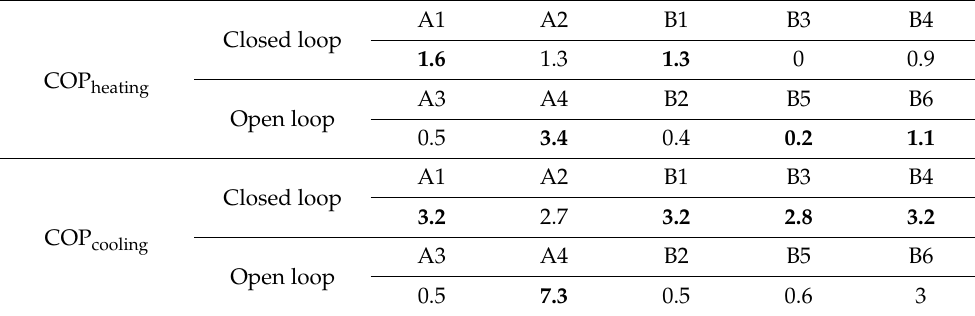
Table 4. Relation between Open/Closed loops and maximum COP heating / cooling